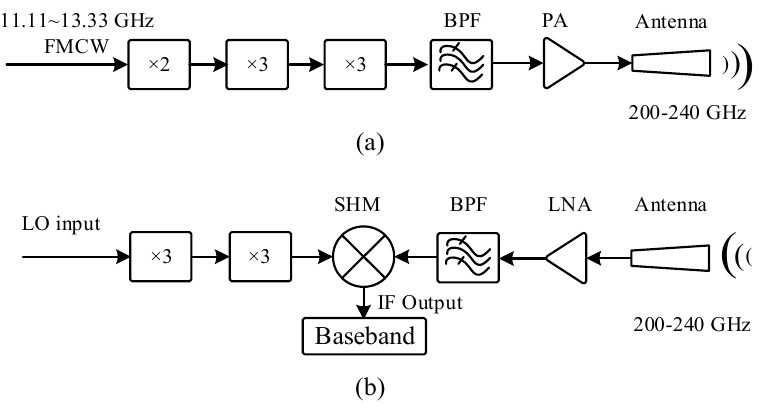
Figure 18. Block diagram of the developed 200–240 GHz FMCW terahertz remote sensing system for security check applications: ( a ) transmitter; ( b ) receiver.